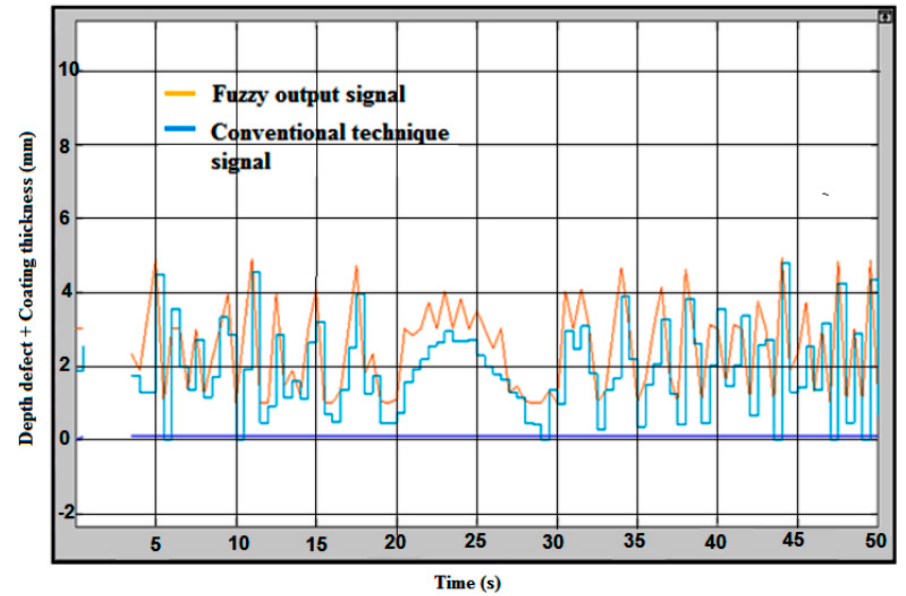
Figure 13. Fuzzy Logic for Error Compensation Signal Output with Coating Thickness.